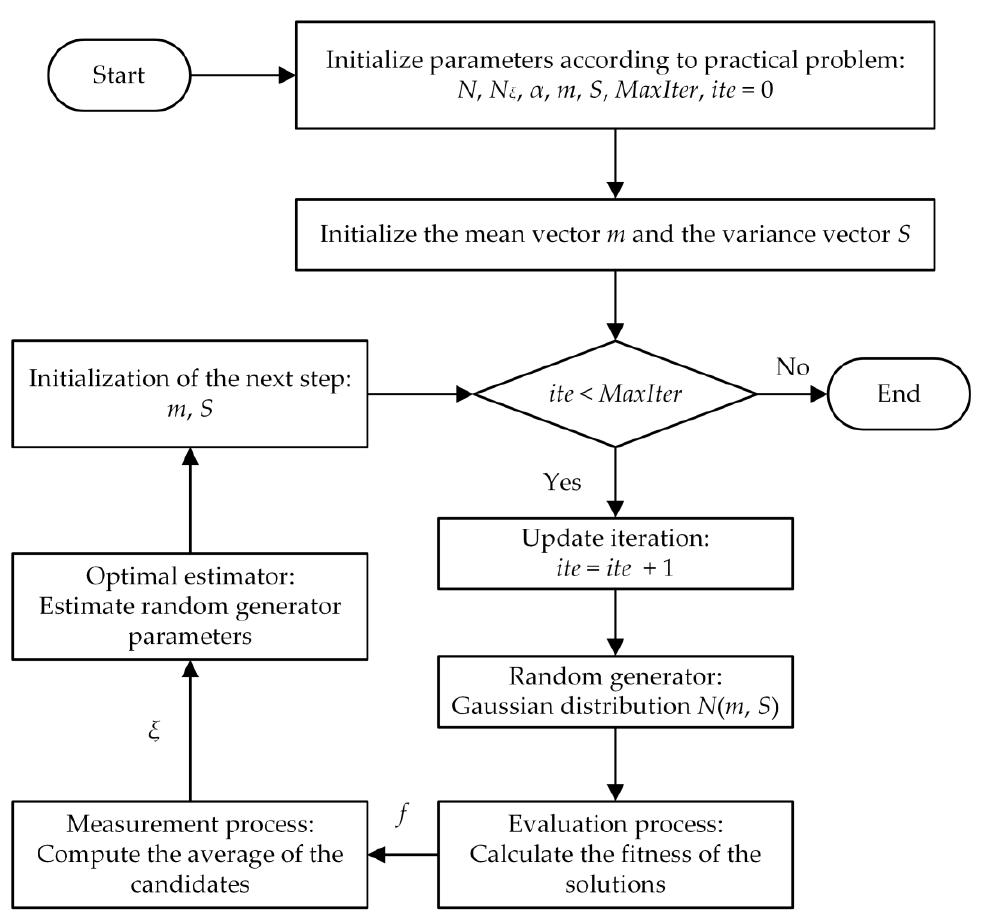
Figure 2. The flowchart of the HKA.